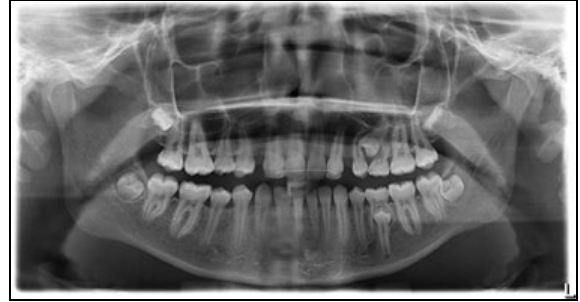
Figure 1. Panoramic radiograph at the age of 16.